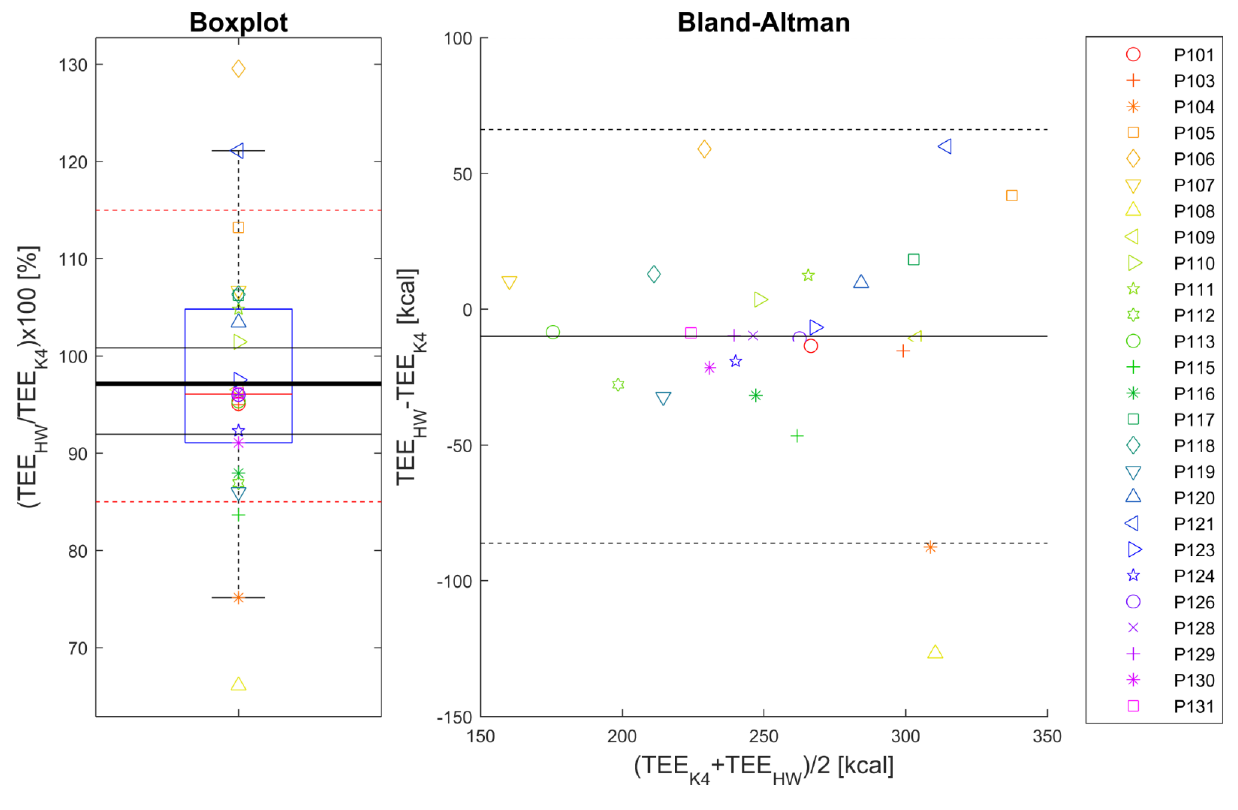
Figure 2. Boxplot (left-hand panel) of the ratio of cumulative total energy expenditure (TEE) between the Philips health watch (HW) and the K4b2 (K4) reference. The thick black line indicates the mean of the data, the red dashed lines the predefined ±15% equivalence interval, and the other thin black lines represent the calculated 95% CI of equivalence. Right-hand panel: Bland-Altman plot of the cumulative TEE for the HW and the reference. The solid black line indicates the average bias and the dashed black lines represent the 95% limits of agreement. Symbols represent participants’ individual data as indicated in the legend and are the same for both